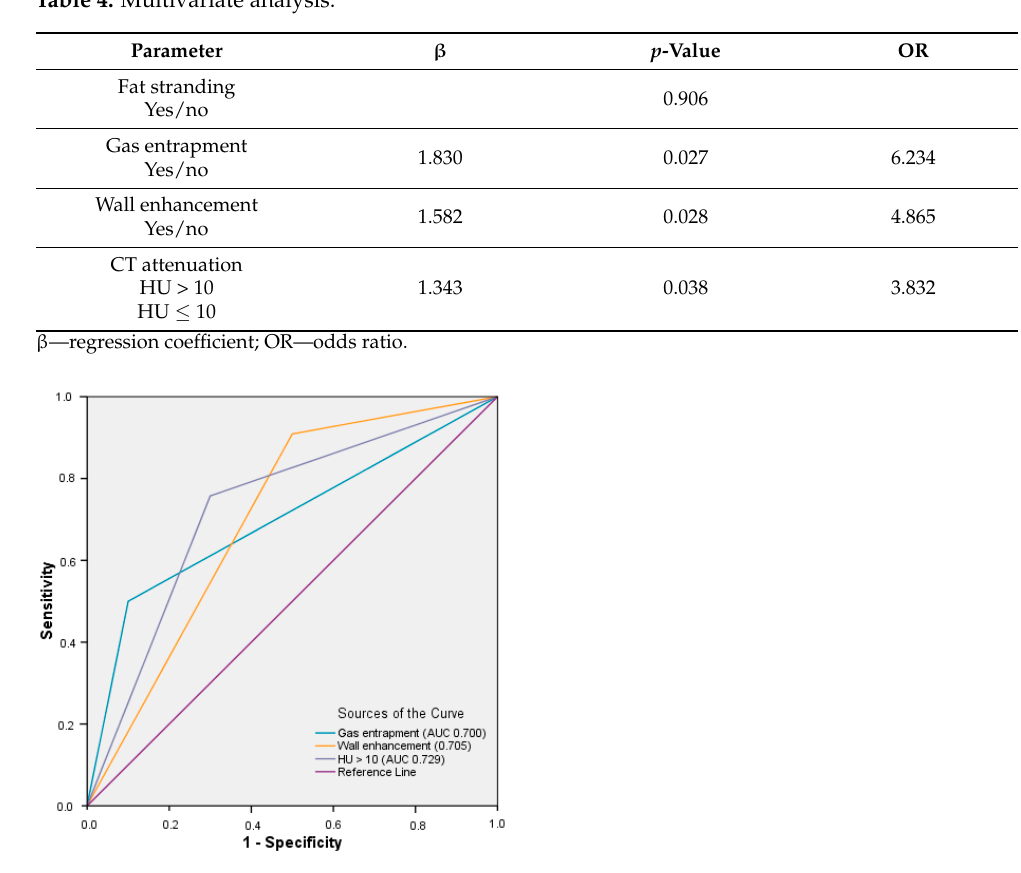
Table 4. Multivariate analysis.